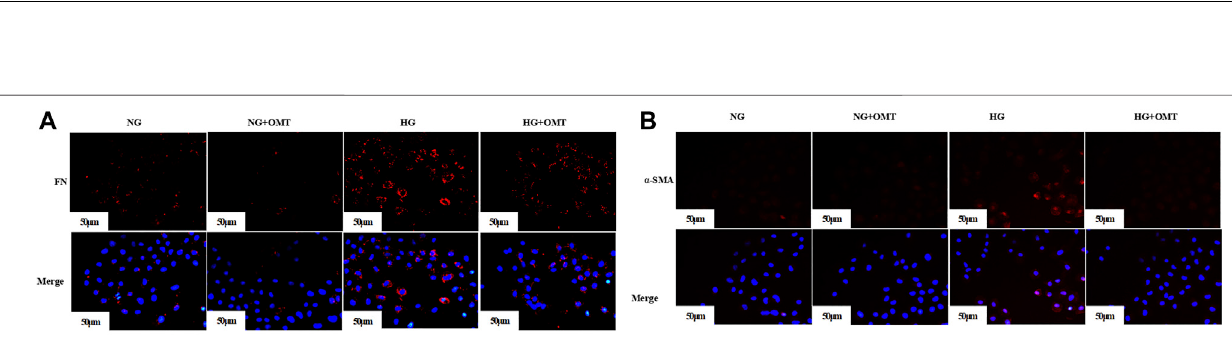
Frontiers in Pharmacology |